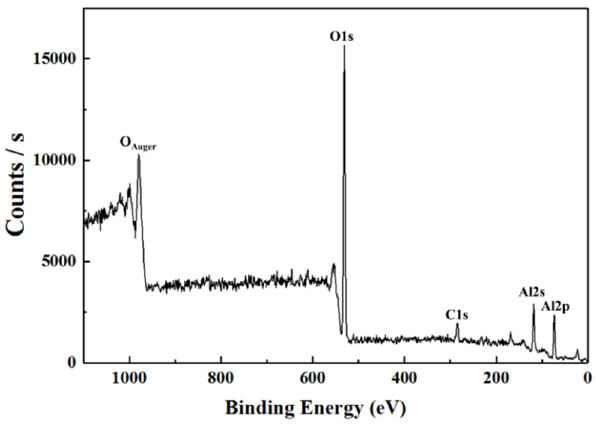
Figure 4. XPS spectrum of AAO film with the addition of 3mM Ce ions.